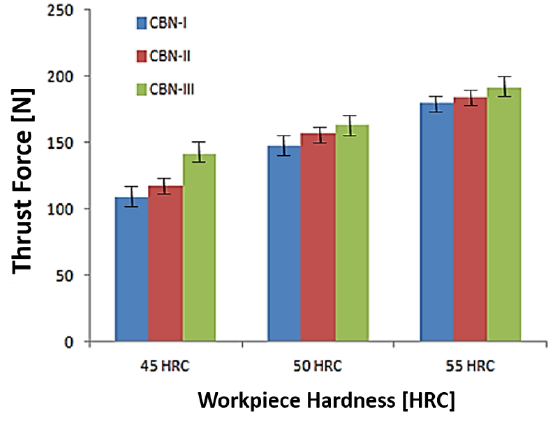
Figure 9. Comparisons of Thrust Force (Ft) with different CBN insert corresponding to workpiece Hardness.